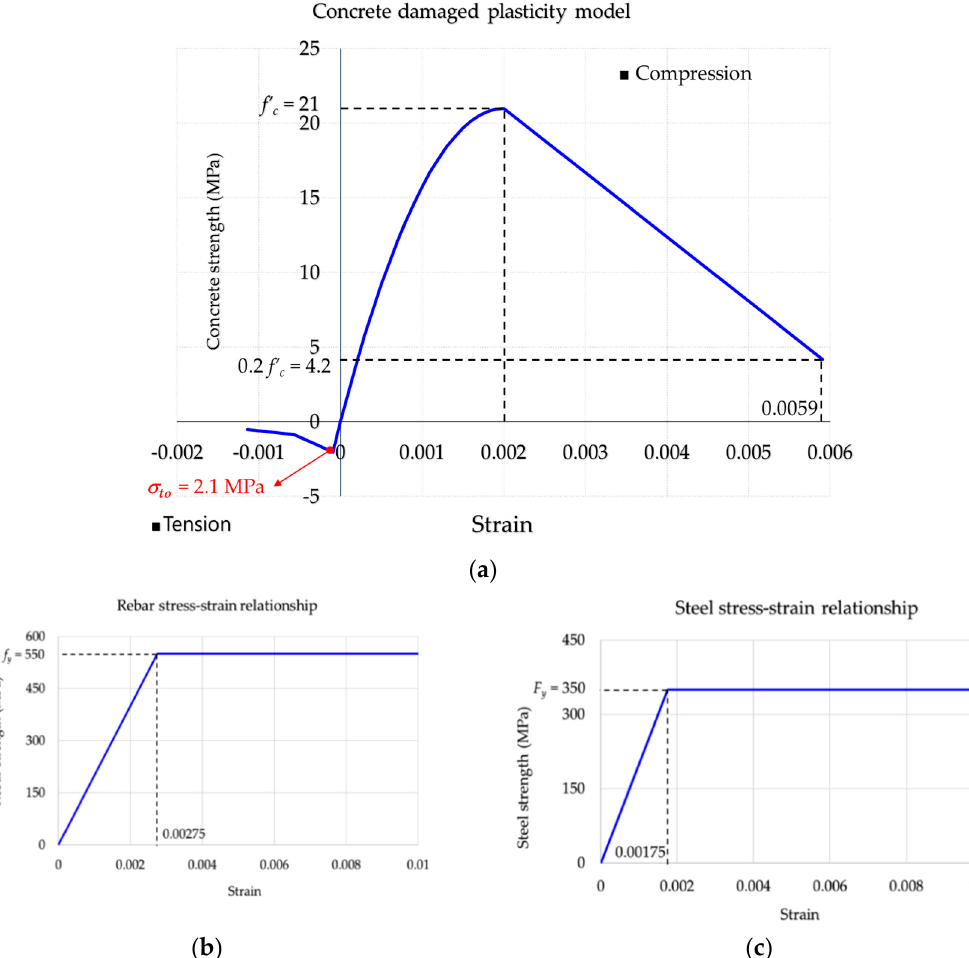
Figure 5. Materials model using in ABAQUS : ( a ) Concrete material model; ( b ) rebar material model; ( c ) steel material model.